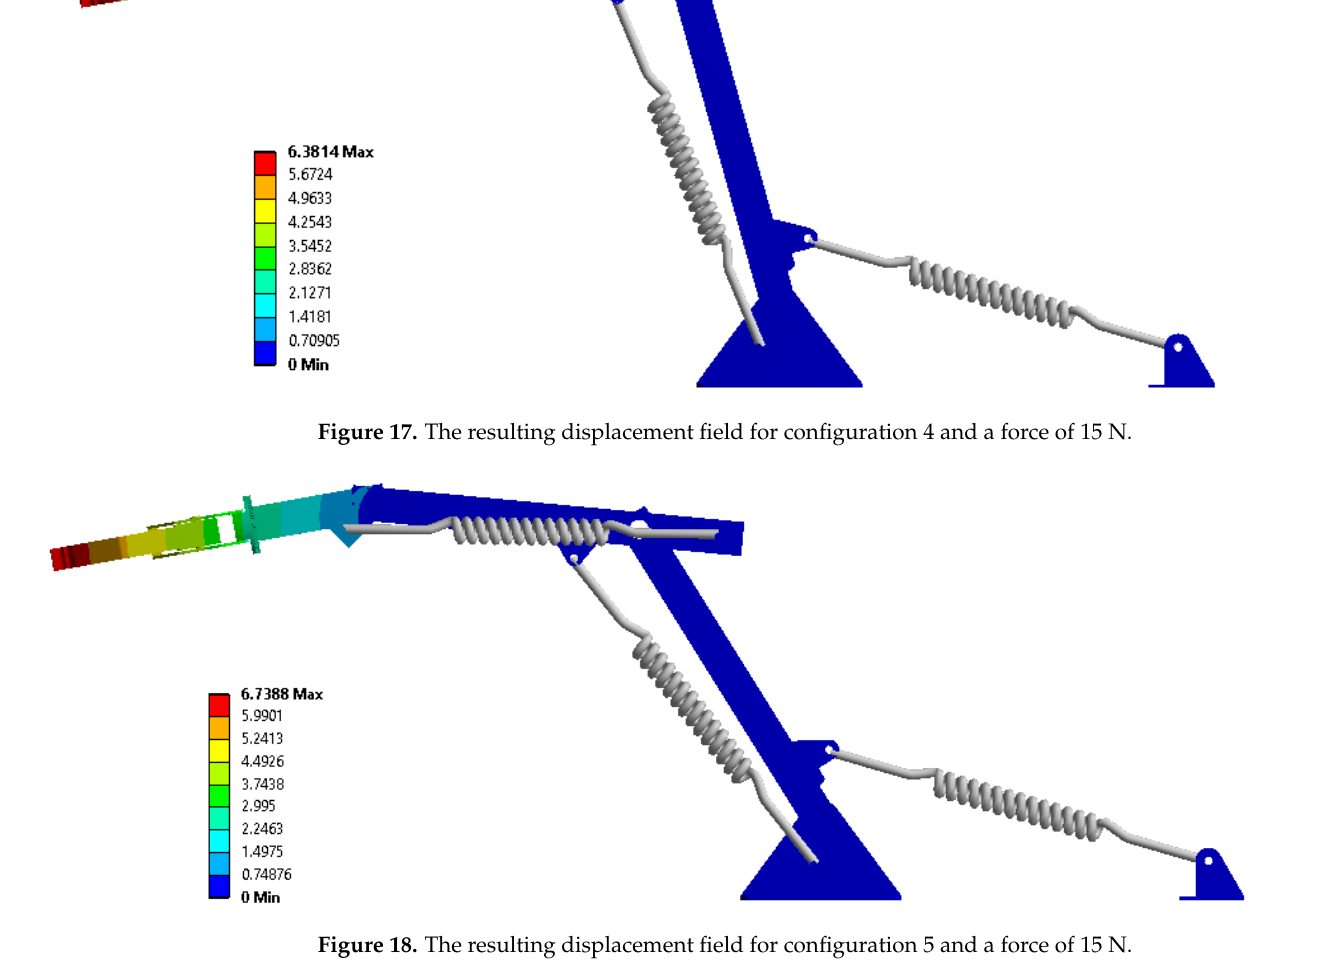
Figure 18. The resulting displacement field for configuration 5 and a force of 15 N.